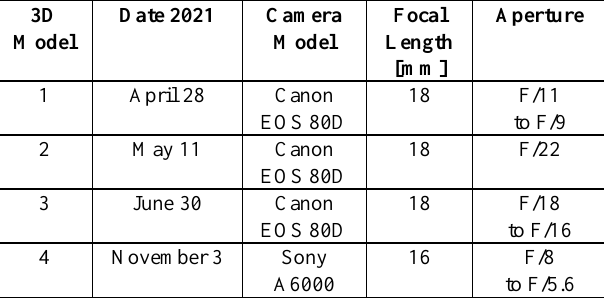
Table 1 . Technical data of used